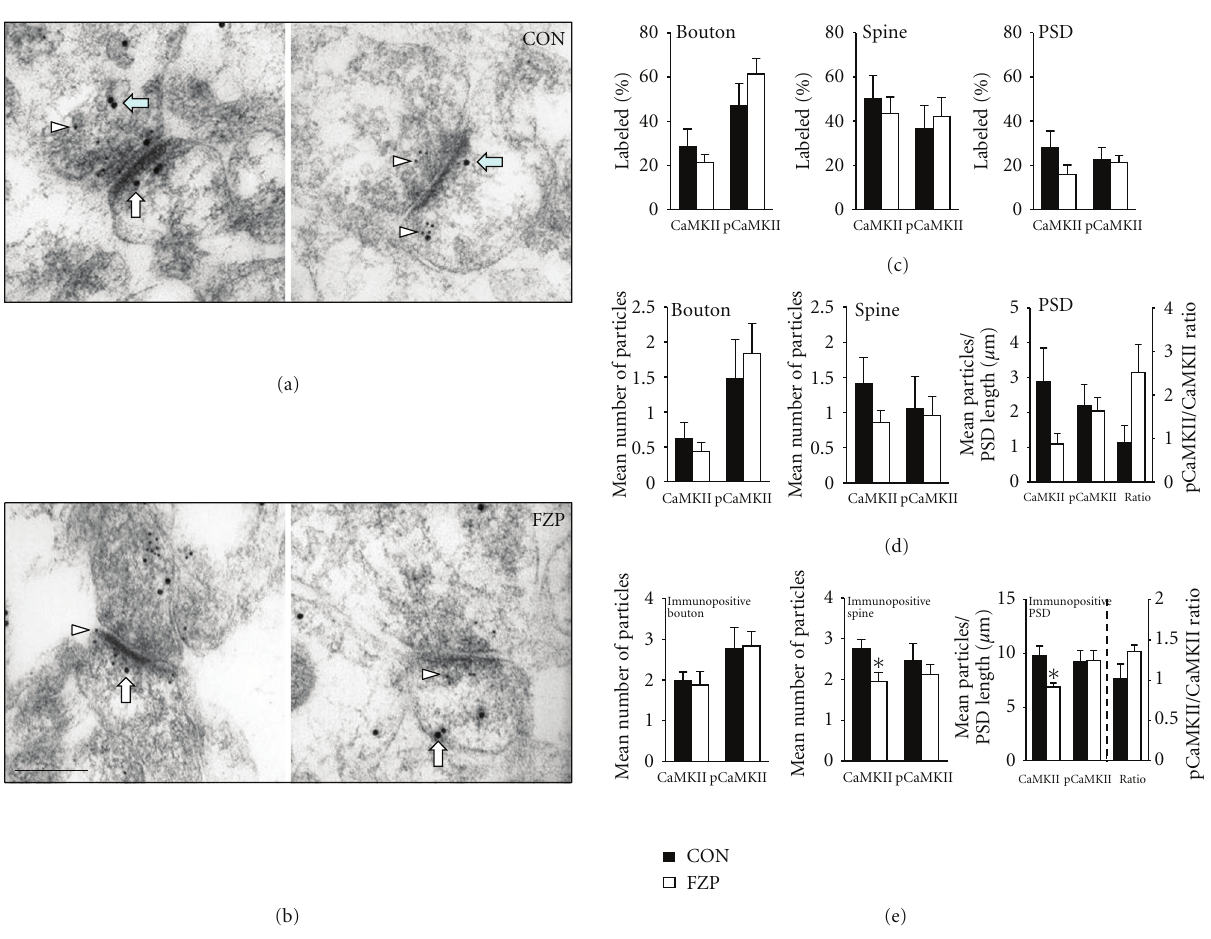
Figure 1: Images of asymmetric synapses in the CA1 SR of control (a) and 2-day FZP-withdrawn (b) rats colabeled with anti-CaMKII α (1:20, recognized with 15 nm gold, arrows) and anti-pCaMKII antibodies (1:10, recognized with 10 nm gold, arrowheads). CaMKII and pCaMKII immunogold particles were observed pre- and postsynaptically, both intracellularly and associated with the membrane and PSD. Scale bar = 0.2 μ m. (c) There was no significant change in the percent of boutons, spines, or PSDs labeled with either CaMKII or pCaMKII ( P > 0 . 05 in each case). (d) There was a nonsignificant decrease in CaMKII labeling in spines (CON: 1 . 41 ± 0 . 36 particles, n = 5; FZP: 0 . 86 ± 0 . 17 particles, n = 5; P = 0 . 20), as well as decreased CaMKII immunogold particles/PSD length (CON: 2 . 88 ± 0 . 97 particles/ μ m, n = 5; FZP: 1 . 10 ± 0 . 29 particles/ μ m, n = 5; P = 0 . 12). However, without an alteration in pCaMKII labeling there was no change in the pCaMKII/CaMKII ratio in PSDs of 2-day FZP-withdrawn rats (CON: 1 . 14 ± 0 . 48, n = 5; FZP: 2 . 52 ± 0 . 64, n = 5; P = 0 . 12). (e) Analysis of immunopositive compartments ( ≥ 1 immunogold particle) revealed a significant decrease in CaMKII labeling in immunopositive spines (CON: 2 . 77 ± 0 . 22 particles, n = 5; FZP: 1 . 94 ± 0 . 23 particles, n = 5; P = 0 . 03) and PSDs (CON: 9 . 77 ± 0 . 92 particles/ μ m; FZP: 6 . 88 ± 0 . 37 particles/ μ m; P = 0 . 02) from 2-day FZP-withdrawn rats. However, the ratio of pCaMKII/CaMKII within the PSD was not significantly altered (CON: 1 . 01 ± 0 . 19, n = 5; FZP: 1 . 35 ± 0 . 09, n = 5; P = 0 . 14).